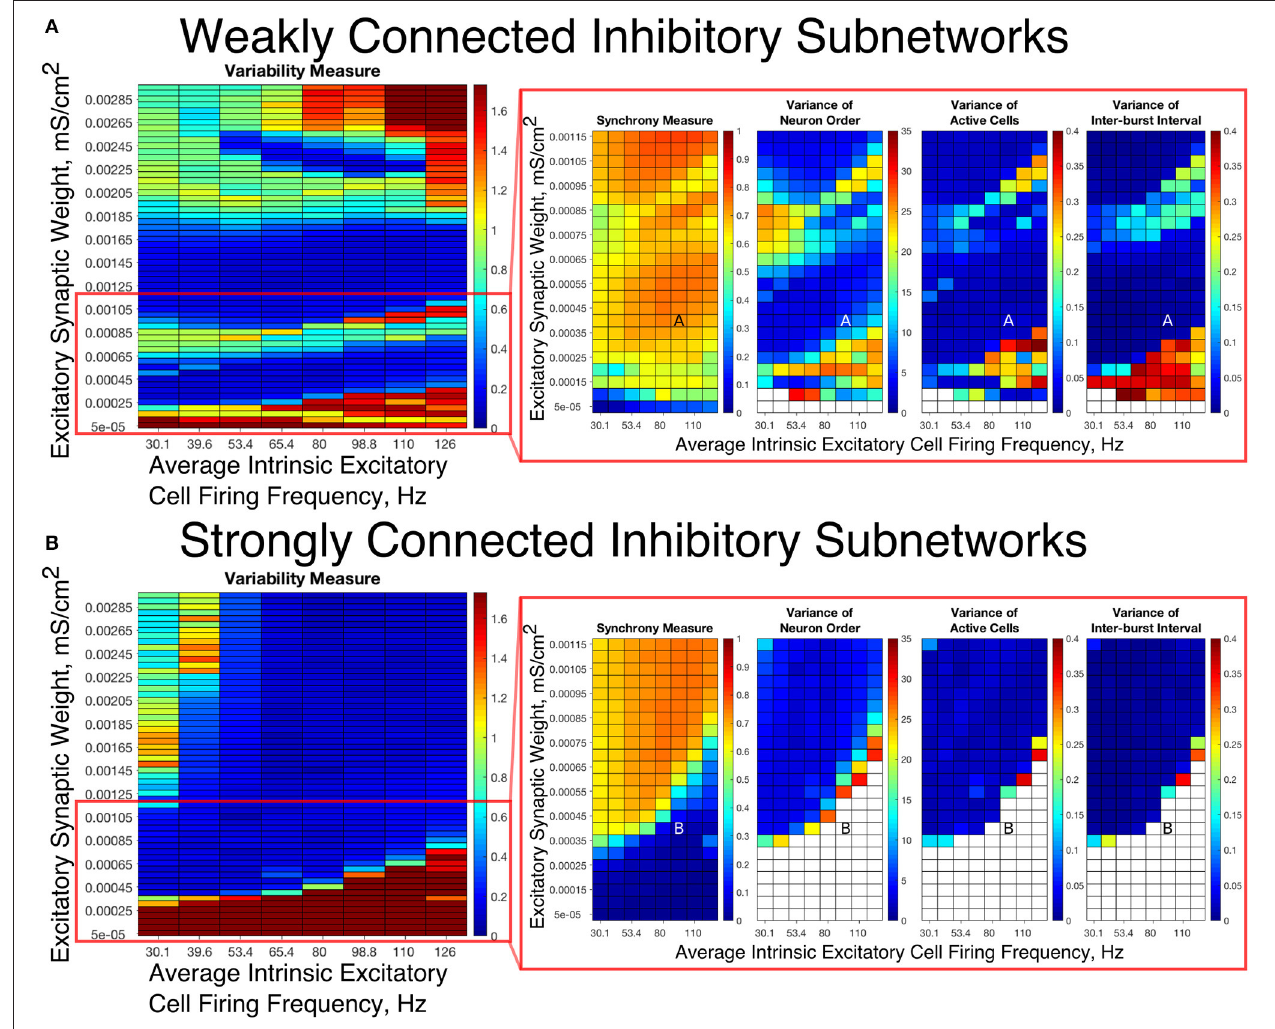
FIGURE 4 | E-I networks with weakly connected inhibitory subnetworks are able to achieve synchrony for low values of the E-I synaptic weight, while E-I networks with strongly connected inhibitory subnetworks are unable to achieve any sort of excitatory bursting activity for many of these networks. (A,B) Variability Measure (left panel) calculated over the entire parameter range studied, with the parameter regime of particular interest outlined in red. For this parameter regime of interest, we show the Synchrony Measure along with the three measures that are used to calculate the Variability Measure (Variance of Neuron Order, Variance of Active Cells, and Variance of Inter-burst Intervals) in the red box making up the right panel. White entries in the heatmaps indicate that the excitatory network did not achieve sufficient synchrony for the given measure to be accurately calculated for that network. Overlaid letters indicate parameter values of example raster plots in Figure 3 . Results for E-I networks with weakly connected inhibitory subnetworks are shown in (A) , while results for E-I networks with strongly connected inhibitory subnetworks are shown in (B) . In the parameter regime of interest, networks with weakly connected inhibitory subnetworks achieve synchrony of the excitatory subnetwork for many network parameters for which networks with strongly connected inhibitory subnetworks are completely